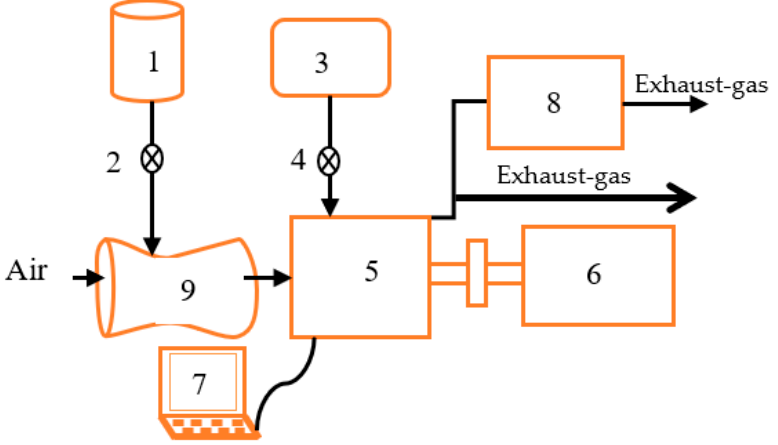
Figure 3. Schematic experimental setup of the test engine. 1 Compressed biogas. 2 Rotameter. 3 diesel